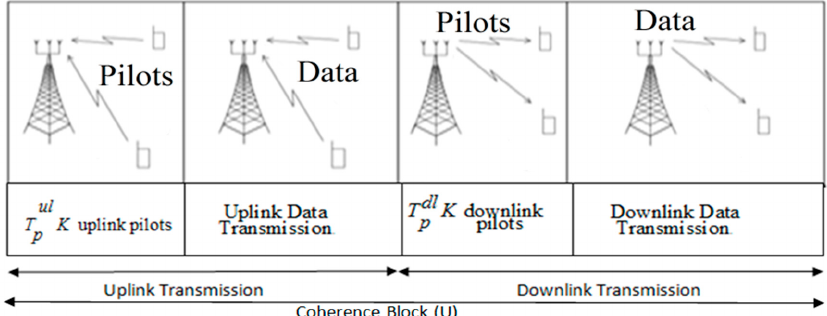
Figure 1. Frame structure of Massive Multiple-Input Multiple-Output (MIMO) in the case of TDD protocol.